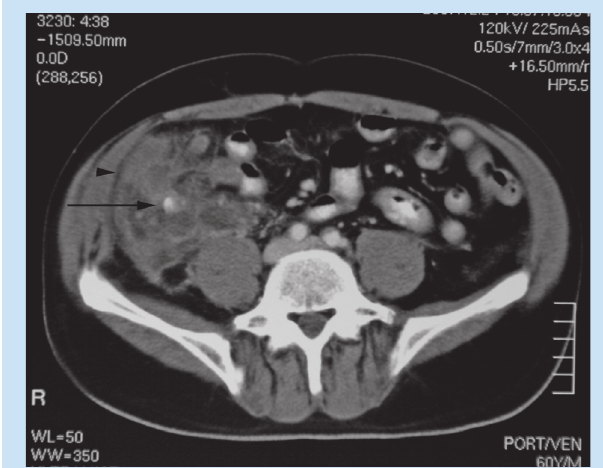
Fig. 4. CT scan of the abdomen. The inflamed base of the caecum is seen (arrowhead) with an appendicolith present within the appendix (arrow). Extensive periappendiceal inflammatory fat stranding and fluid are present.